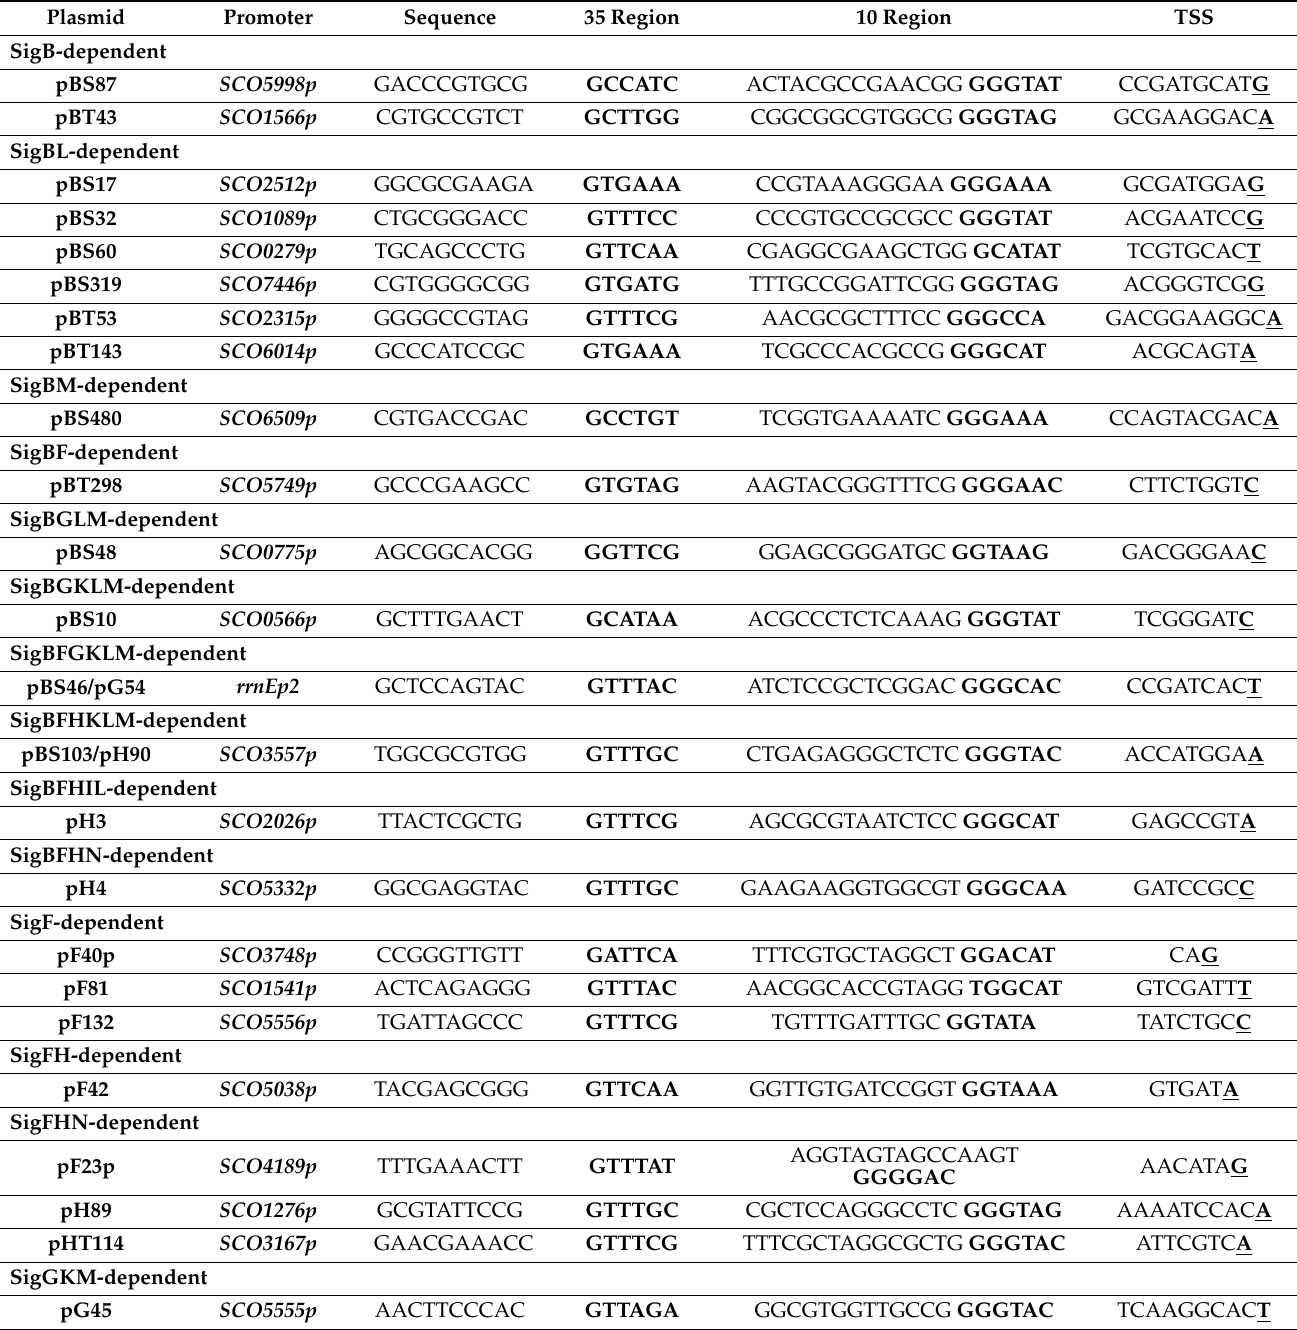
Table 2. Comparison of promoters dependent on several groups of SigB homologous sigma factors from S. coelicolor A3(2).